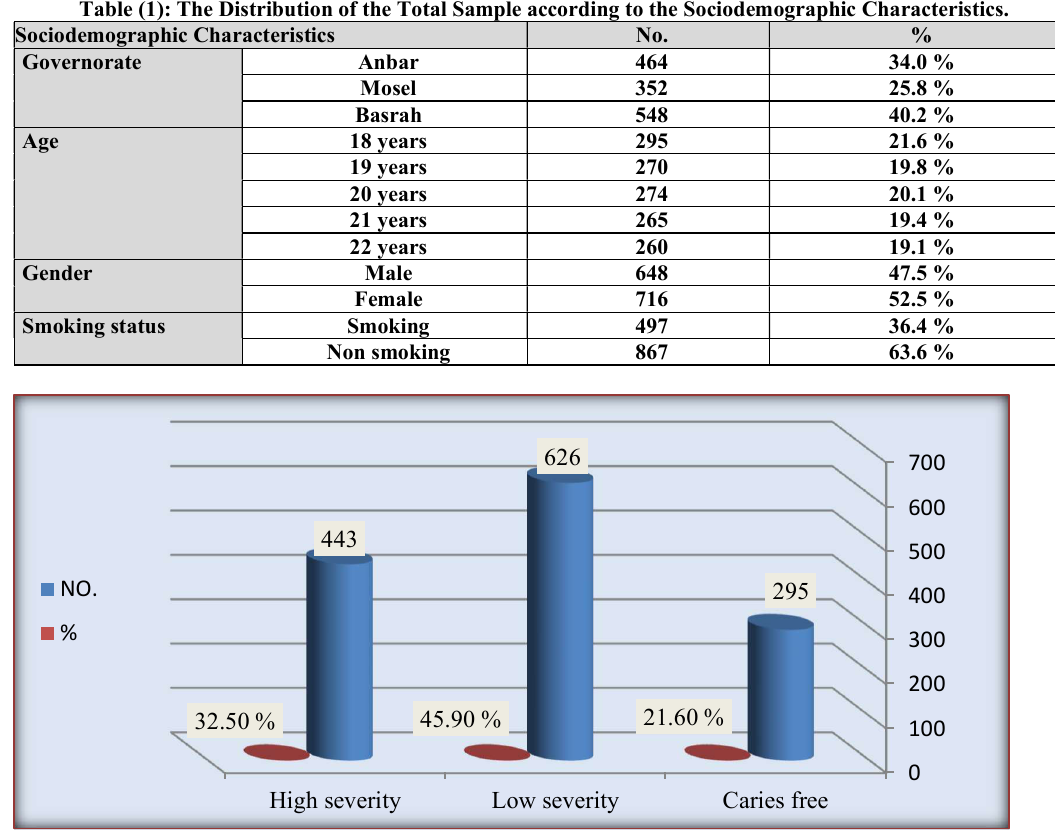
Figure (1): The distribution of dental students according to caries severity